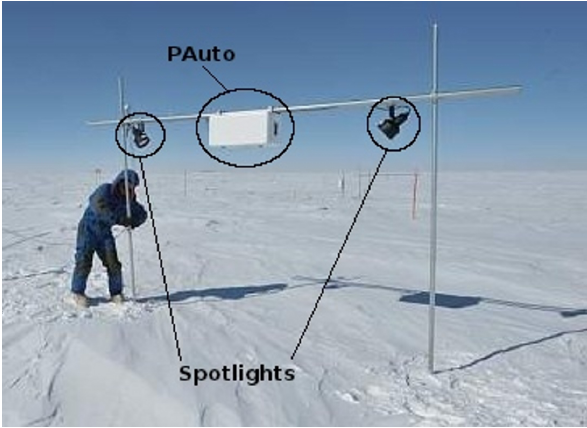
Fig. 3. PAuto: experimental device taking hourly near-infrared pic- Fig. 3 : PAuto: experimental device taking hourly near-infrared pictures of the snow surface at tures of the snow surface at Dome C. The white box contains the DomeC.Thewhiteboxcontainsthecamera, computer, GPSandheating. Thetwonear-infrared camera, computer, GPS and heating. The two near-infrared spot- spotlights provide illumination during the night. lights provide illumination during the